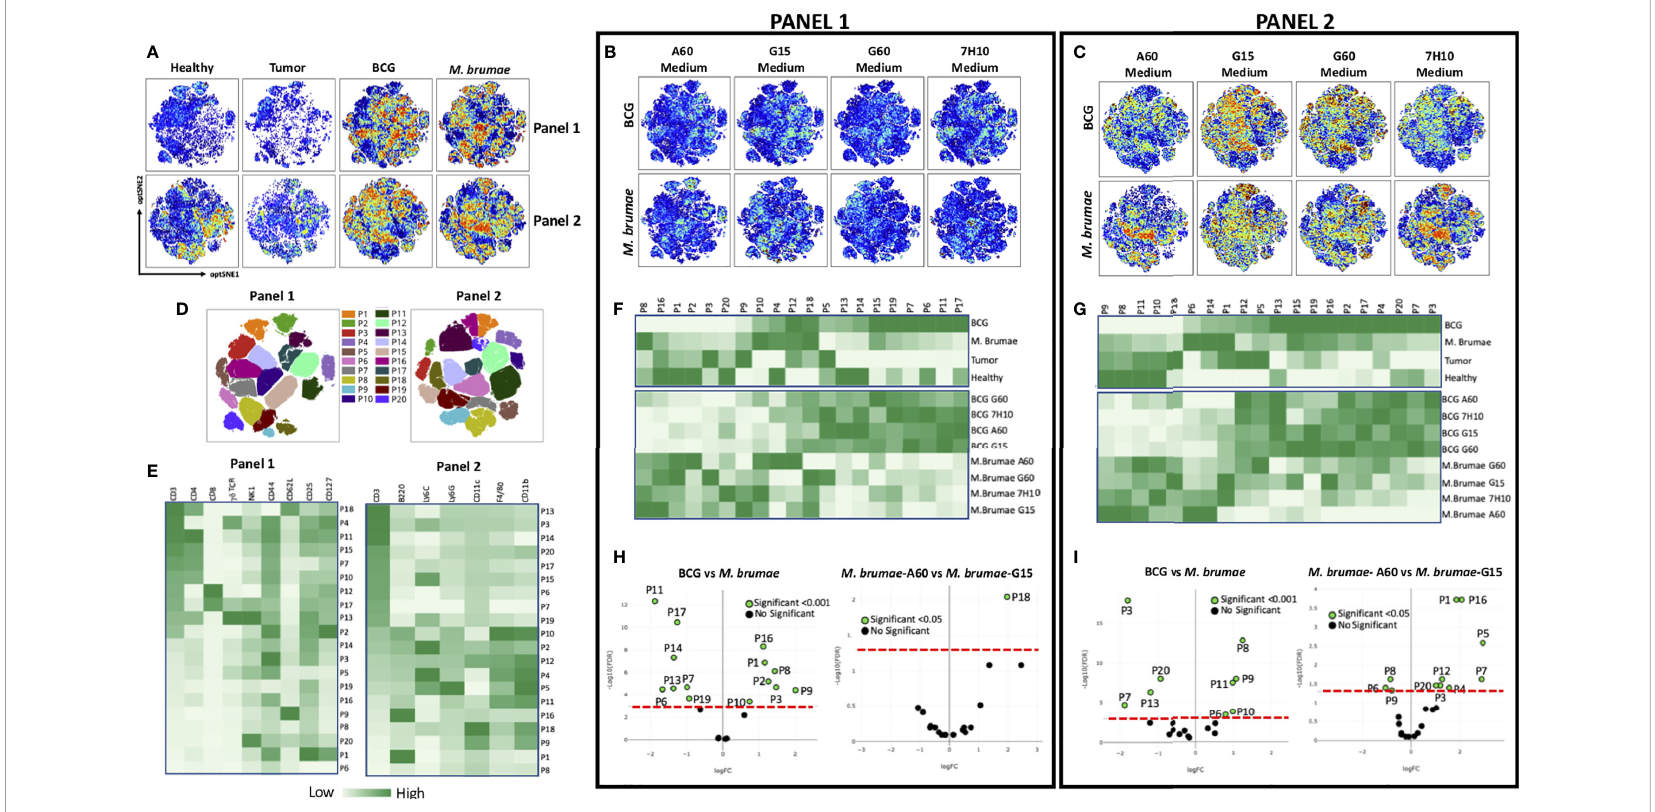
FIGURE 2 Global pro fi le of bladder in fi ltrating immune cells. opt-SNE was used for the analysis of the immune in fi ltration into the bladder of healthy, non-treated and mycobacteria-treated tumor-bearing mice. Cells were stained using two panels of antibodies (Supplementary Table 1), measured by fl ow cytometry and analyzed using OMIQ software. (A) opt-SNE maps showing expression intensity of all markers from both antibody panels of concatenated fi les for all healthy animals, non-treated and all BCG- or M. brumae -treated mice, in multidimensional space. (B) The same opt-SNE maps with the expression intensity using panel 1 antibodies and (C) using panel 2 antibodies in bladders from mice treated with BCG or M. brumae grown in different culture media (D) Overlay of 20 gated cell populations on to opt-SNE plots for both antibody panels. (E) Heatmaps showing expression intensity in all the populations gated in D) for all the markers using both antibody panels. Color-coded with dark green for higher expression and light green for lower expression. (F) Heatmaps displaying frequency for all the populations gated in D) among bladders from all animal groups using panel 1 and (G) using panel 2 antibodies. (H) Volcano plots showing adjusted p values versus log (Fold Change; FC) for immune populations in different groups of animals using panel 1 and (I) panel 2 antibodies. Populations whose expression is signi fi cantly different between group of animals with a adjusted p < 0.05 or p < 0.00 are shown in green. The red line denotes a p value of 0.001 or